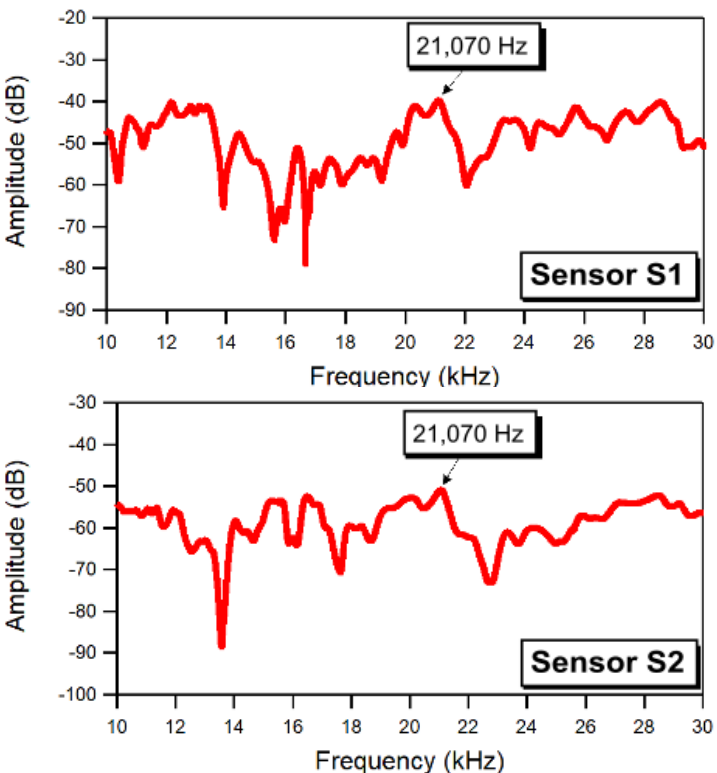
Figure 7. Spectral responses of the beam in the high frequency range acquired at positions S1 ( top ) and S2 ( bottom ).